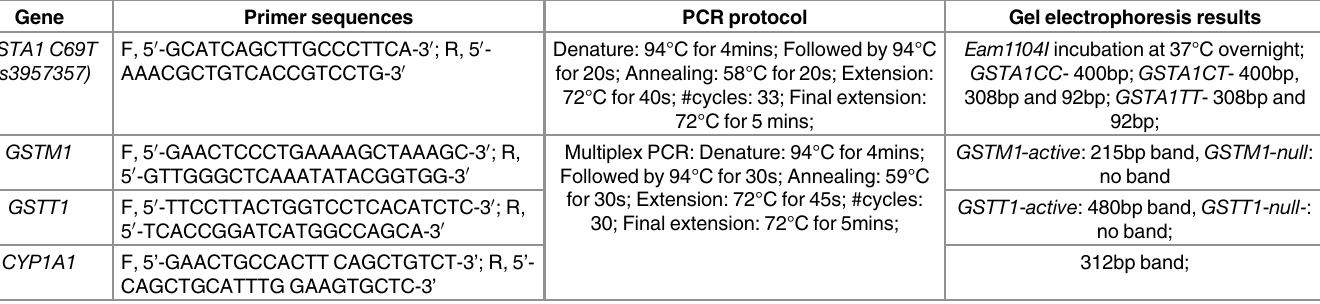
Table 1. PCR: primer sequences, PCR conditions, restriction enzymes and fragment